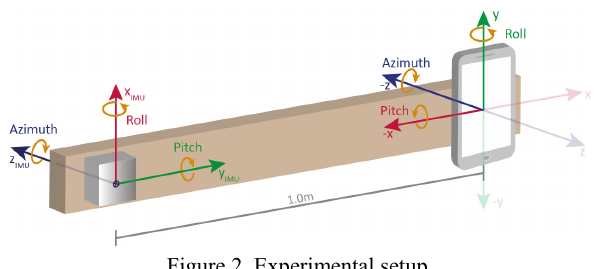
Figure 2. Experimental